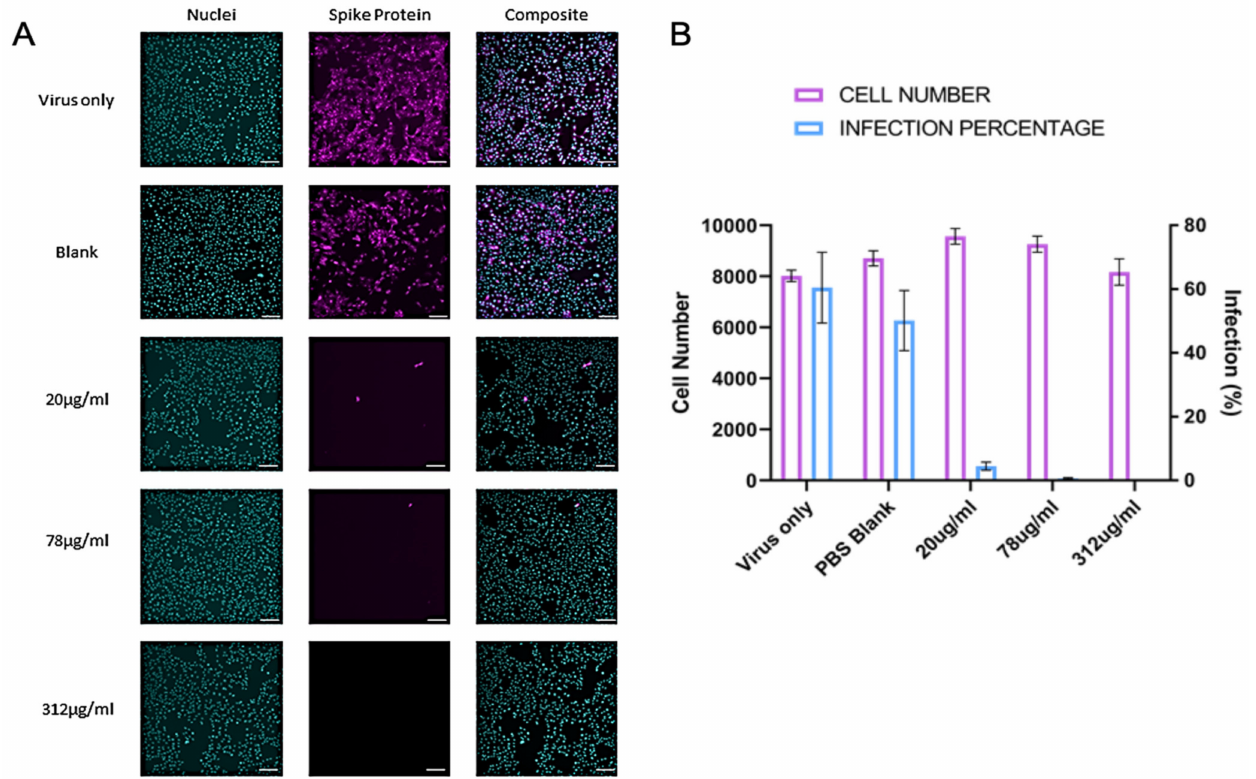
Figure 2. Antiviral activity of rhamnolipids nano-micelles solution prepared at 20, 78, and 312 µ g/mL against SARS-CoV-2. ( A ) Representative immunofluorescence images for infected Vero cells where nuclei were detected by Hoechst 33342 (Cyan) and SARS-CoV-2 spike protein by rabbit anti-spike antibody detected with anti-rabbit-Alexa-555 secondary antibody (magenta). Scale bars represent 100 µ m. ( B ) Automated quantification of cell number per field of view and % infected cells 48 h after infection. Results are the average of three independent experiments, with three replicates in each. Error Bars represent standard